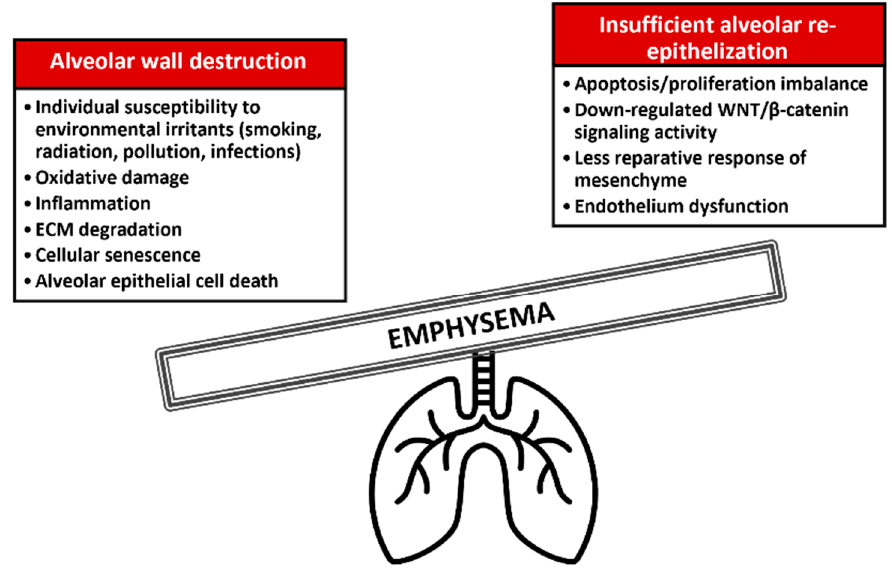
Figure 3. Alveolar wall destruction and impaired re-epithelialization in pulmonary emphysema. Recently, it was demonstrated that endothelium dysfunction increased the severity of emphysematous changes in patients and elastase-treated mice [63]. Delivery of healthy lung endothelial cells reversed alveolar wall destruction, improved lung function, and increased lung elastance in the elastase-induced mouse model of emphysema, possibly through promoting both endothelial and non-endothelial cell proliferation and tissue